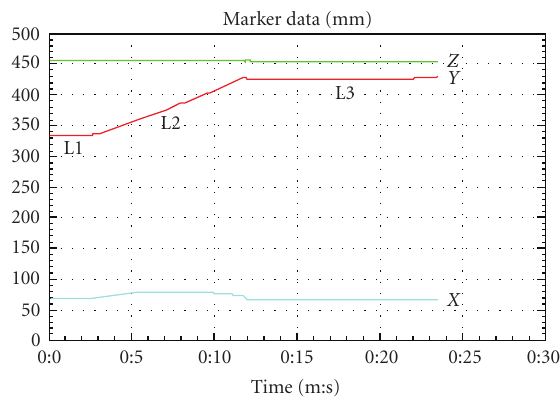
Figure 6: Curve for master robot’s end position during the cooperation and fine adjustments.